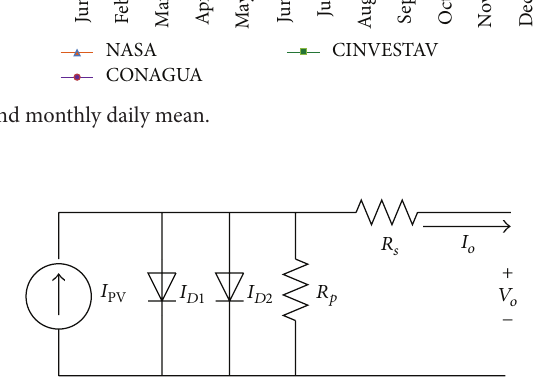
Figure 5: Two diodes’ PV cell equivalent